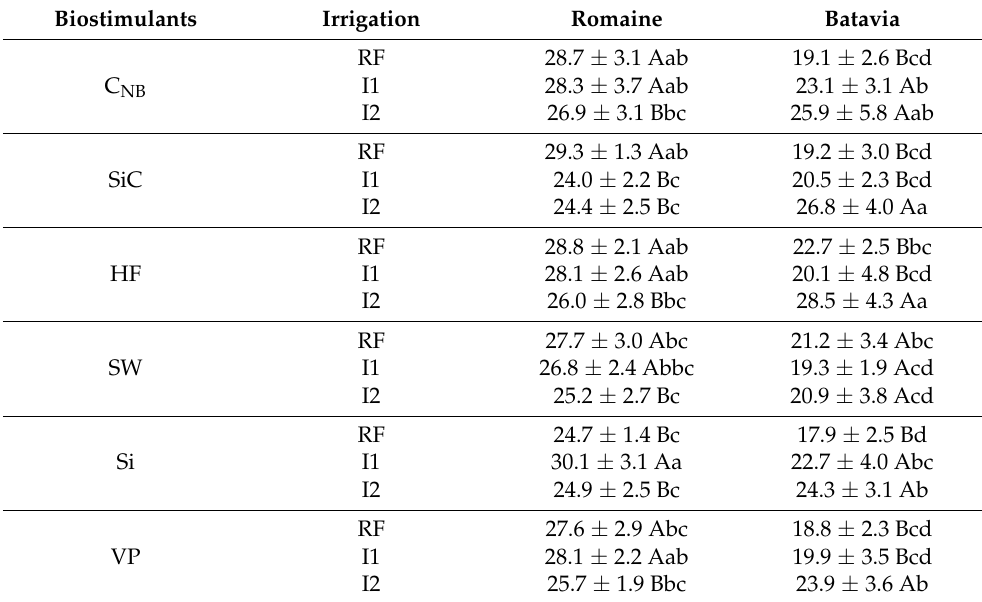
Table 1. Plant height (cm) of lettuce plants at harvest.